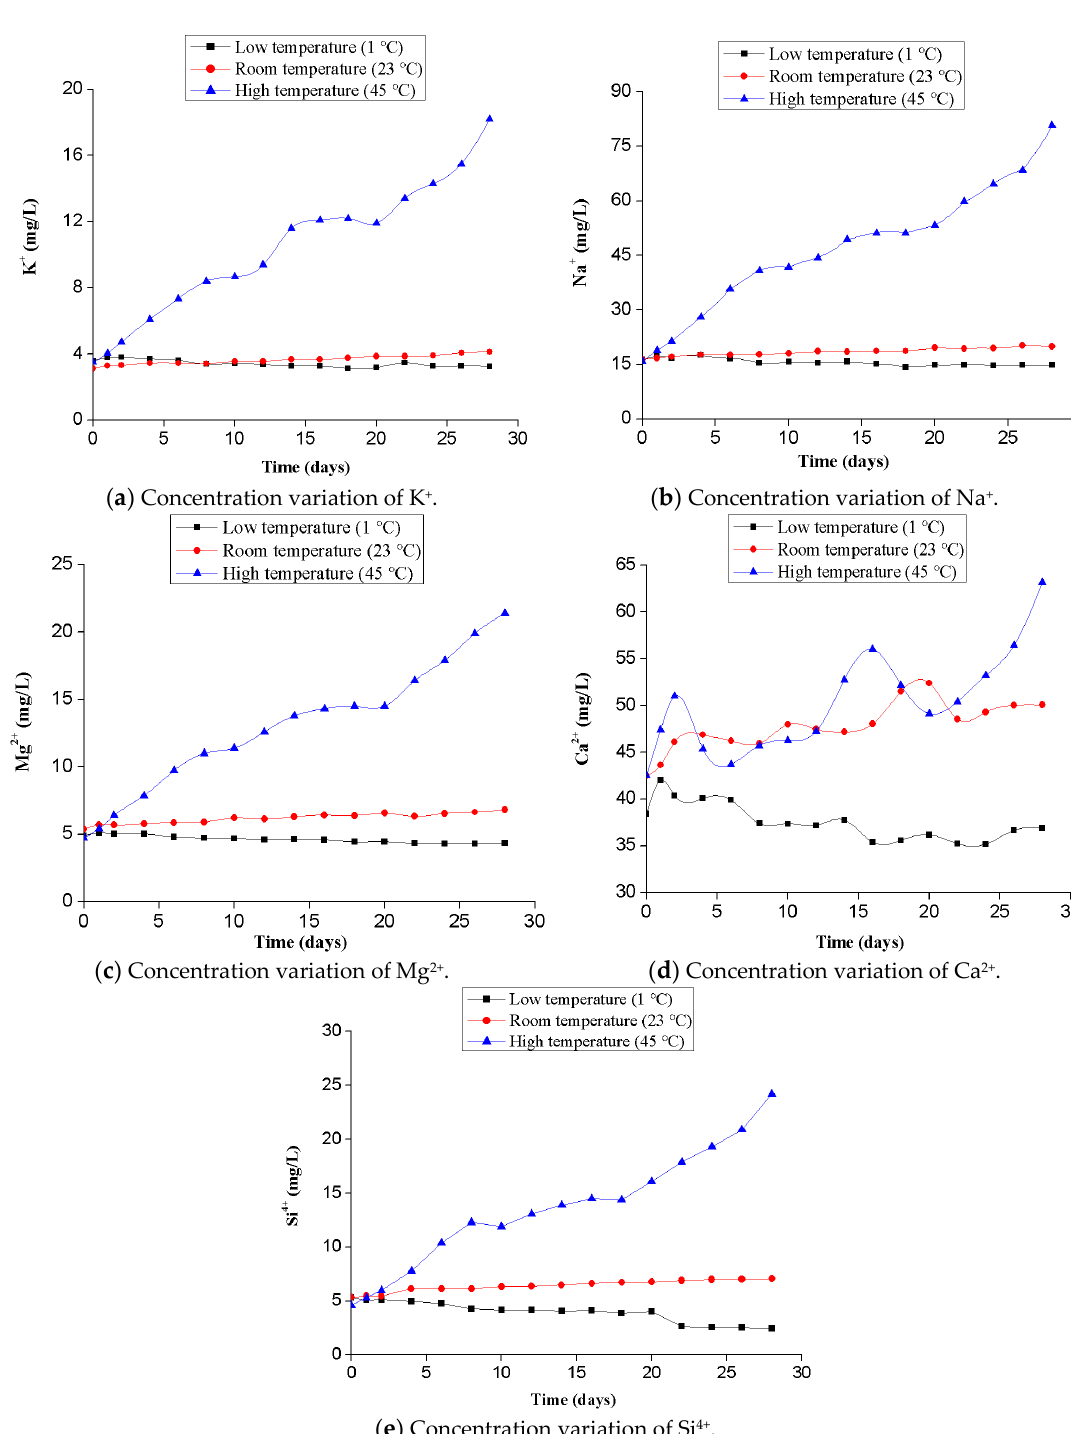
Figure 6. Curve of the main cationic concentration in the circulating aqueous solution at different Figure 6. Curveofthemaincationicconcentrationinthecirculatingaqueoussolutionatdifferenttemperatures. temperatures. (2)